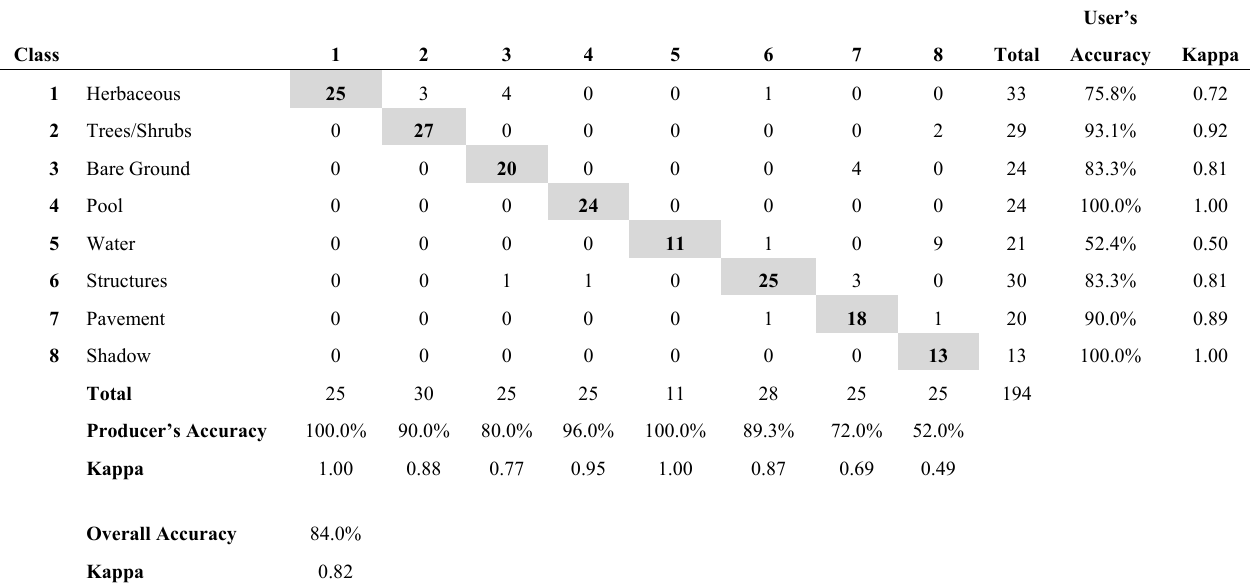
Table 2. Error matrix results for the classification performed with 2007 NAIP multispectral data and NDVI